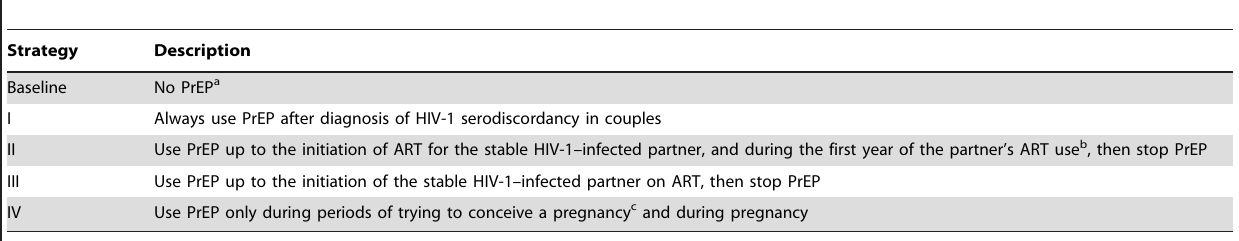
Table 2. PrEP implementation strategies used in the